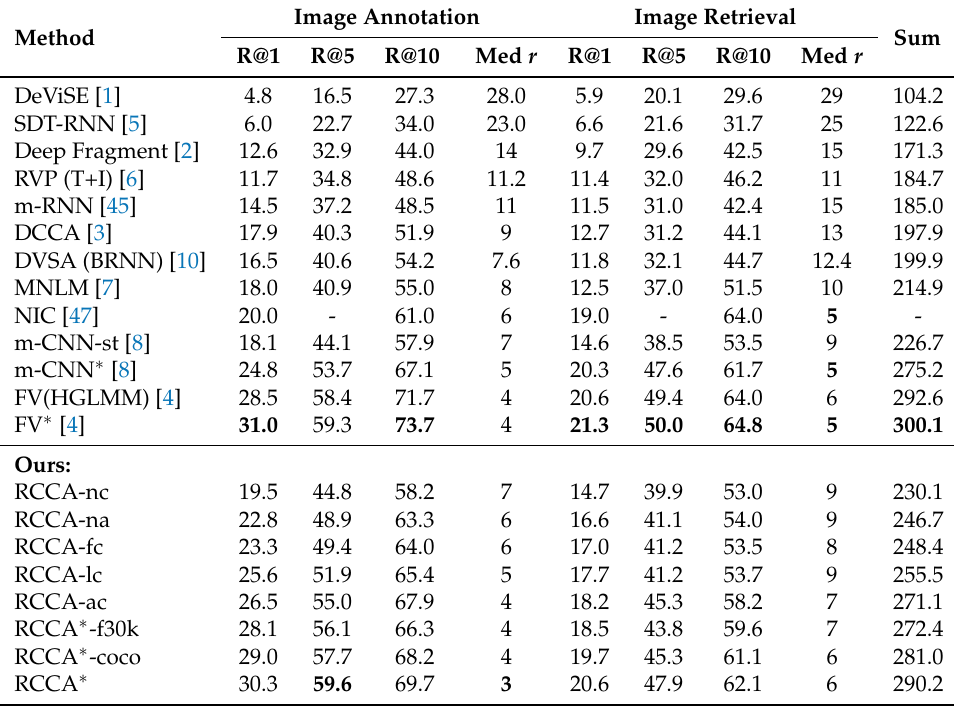
Table 1. Comparison results of image annotation and retrieval on the Flickr8K dataset ( ∗ indicates ensemble or multi-model